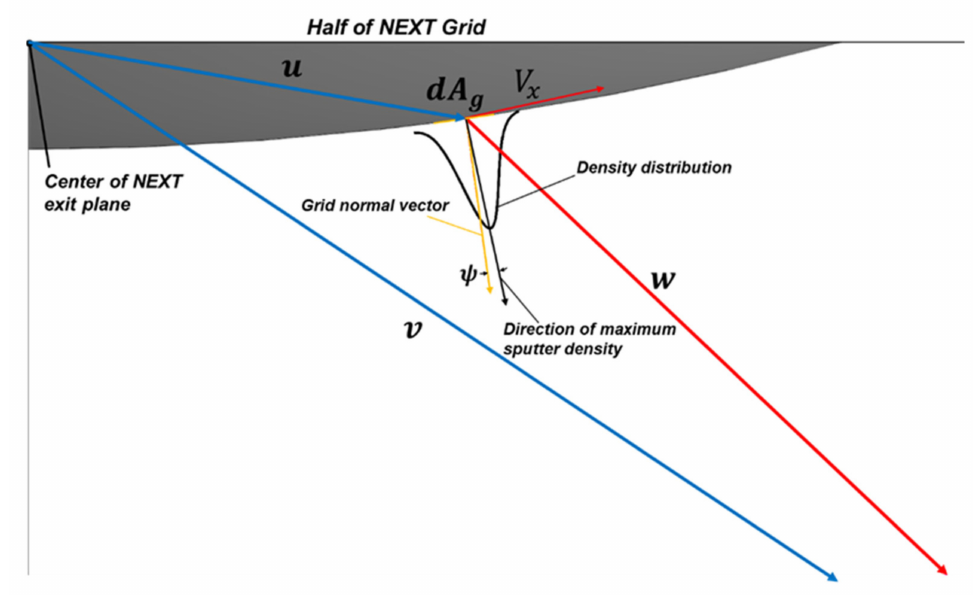
Figure 13. Diagram of one-half of the NEXT grid, and shift of average velocity vector for moly sputter efflux with respect to local grid normal.